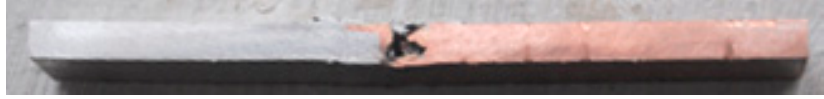
Figure 2. Weld cross section with “0” tool position. Table 2. Al ‐ Cu Welding Parameters in Friction Stir Welding (FSW).